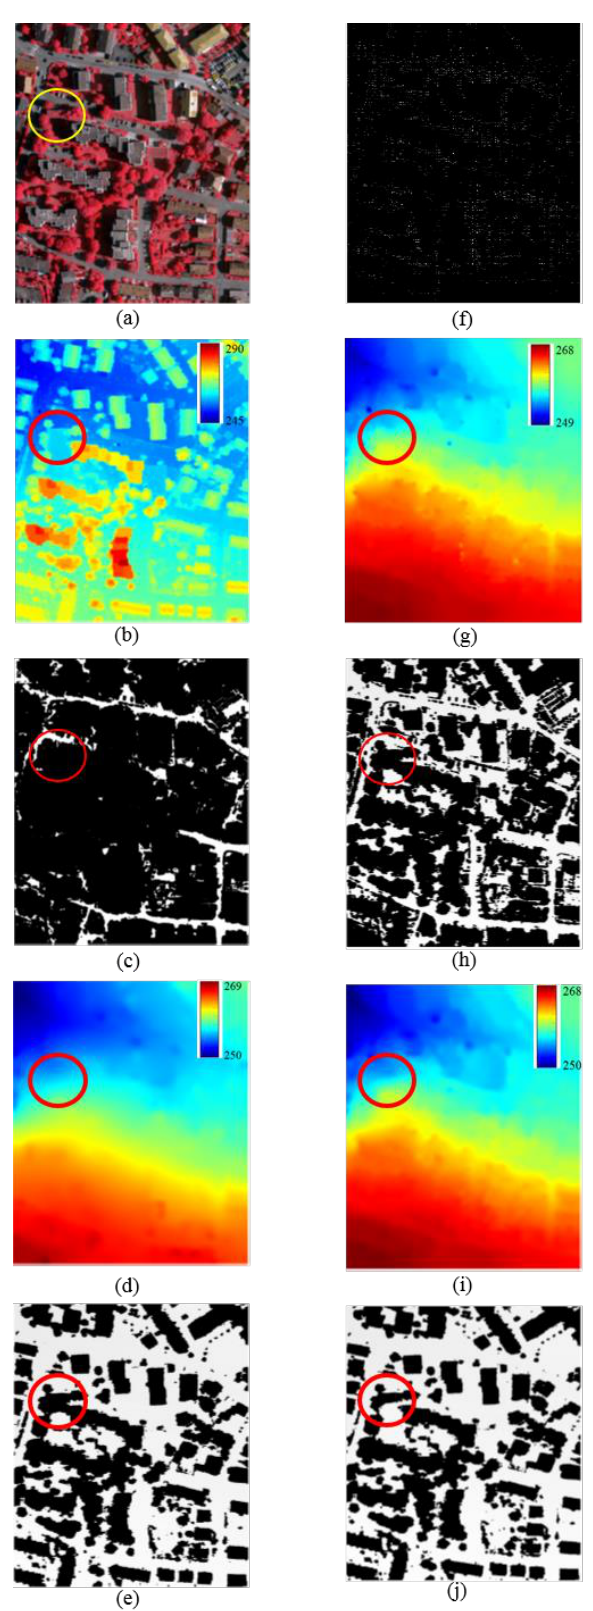
Figure 7. Ortho image for area1 (a) and input DSM (b). Ground mask (c), DTM (d), and nDSM (e) by MSD method.